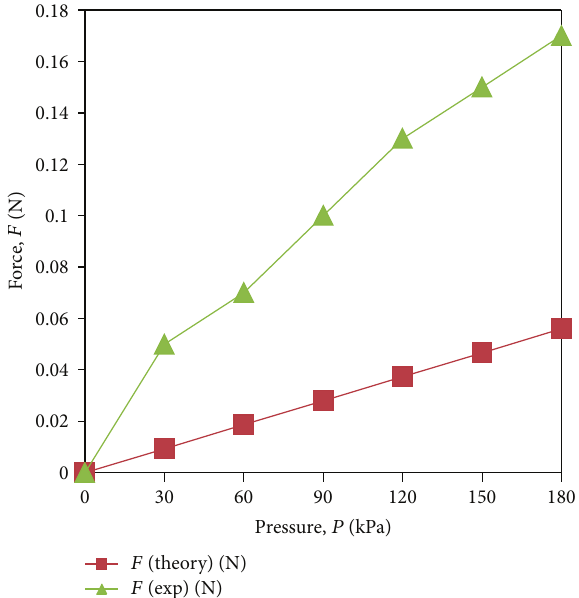
Figure 19: Experimental and theoretical results of force measure-